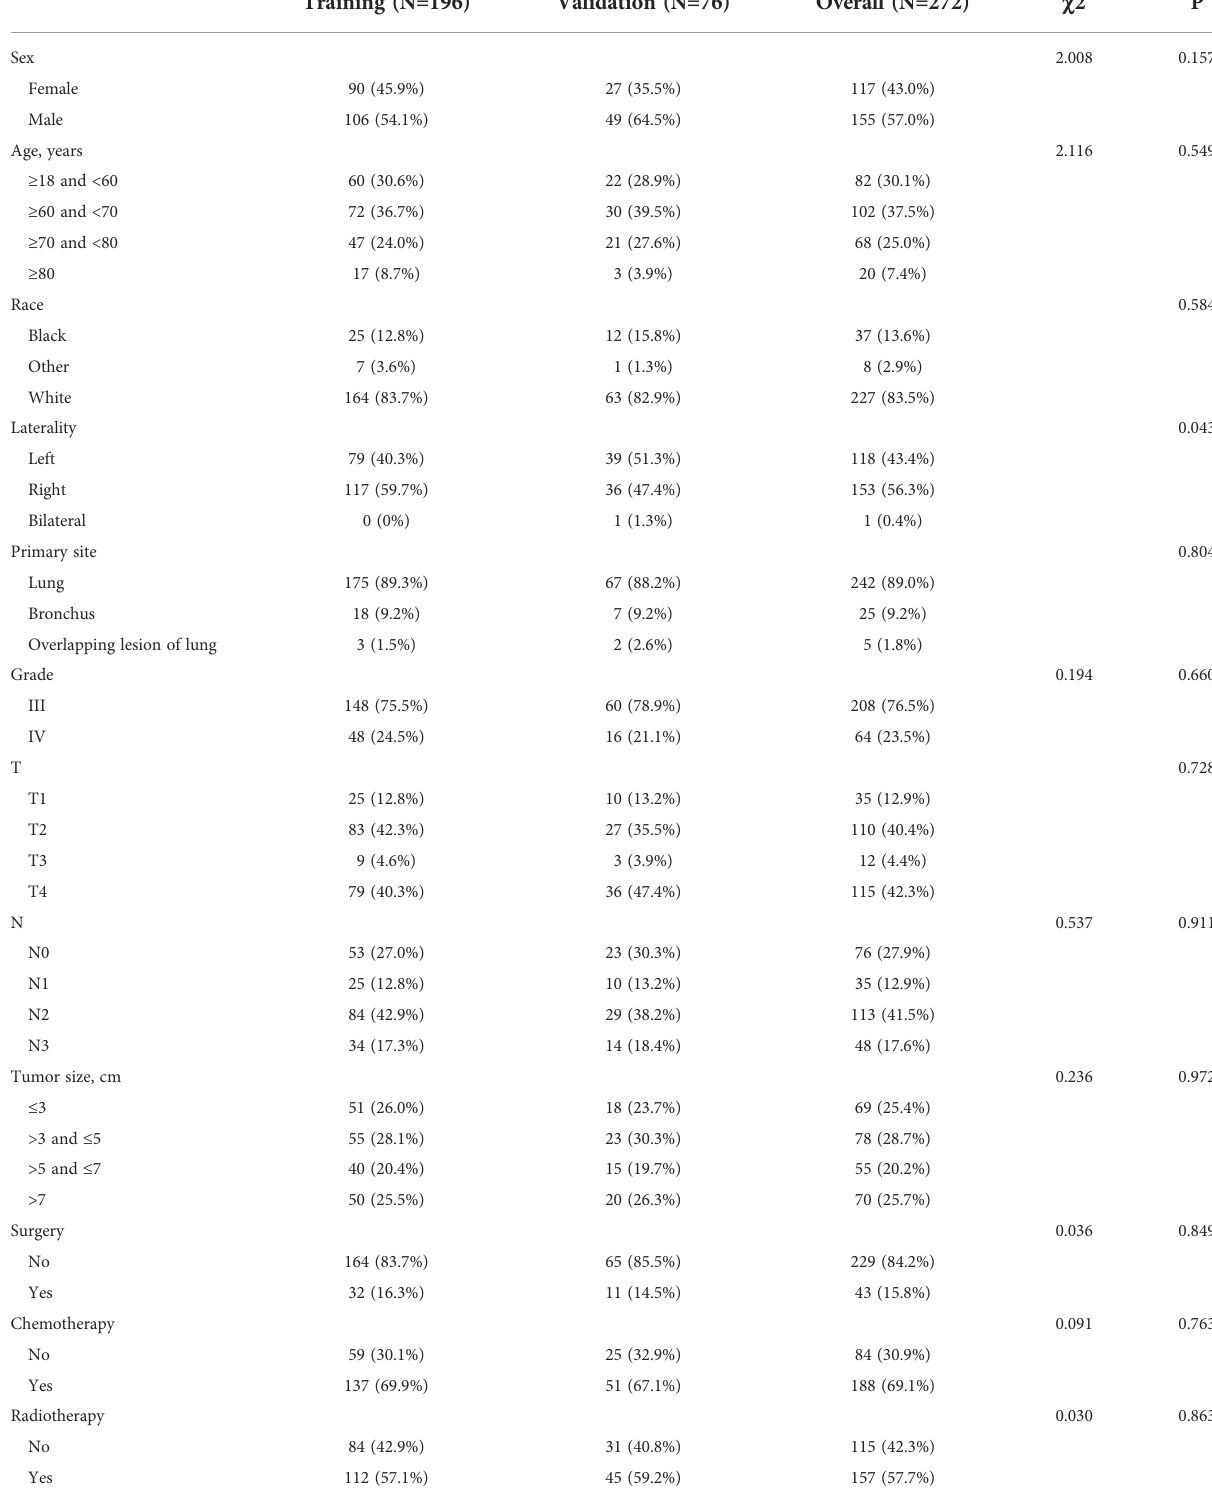
TABLE 2 Baseline characteristics of pulmonary large cell neuroendocrine carcinoma (LCNEC) patients with distant metastasis (in the prognostic